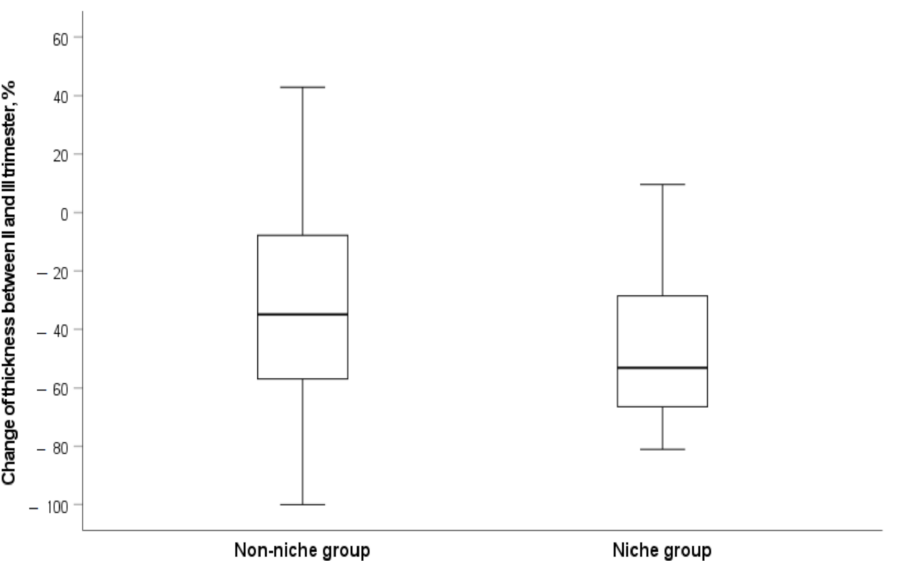
Figure 6. Change in myometrial LUS thickness between the second and third trimester of pregnancy in the CS scar niche group and non-niche group. Data shown as percentage (the more negative percentage, the more significant decrease in myometrial LUS